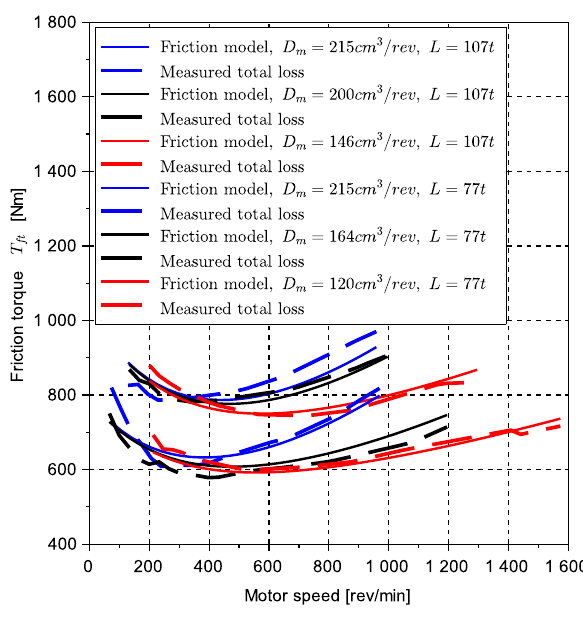
Figure 16: Compared model versus measured results.